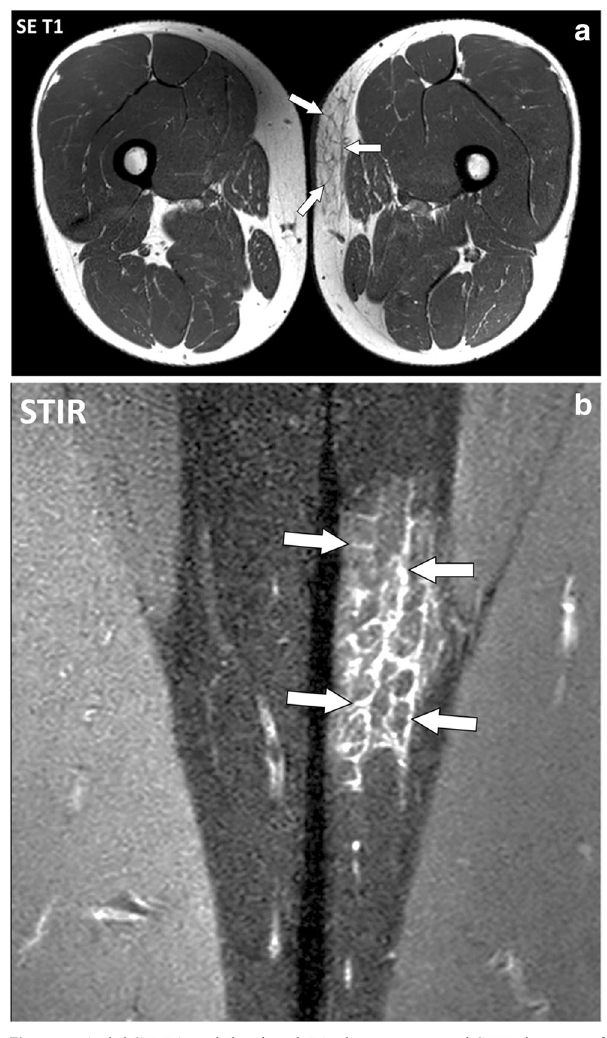
Fig. 9 a Axial SE T1-weighted and ( b ) close-up coronal STIR images of the thighs of a 43-year-old male with dermatomyositis. The fascia superficialis of the left thigh (arrows) is thickened with fluid signal